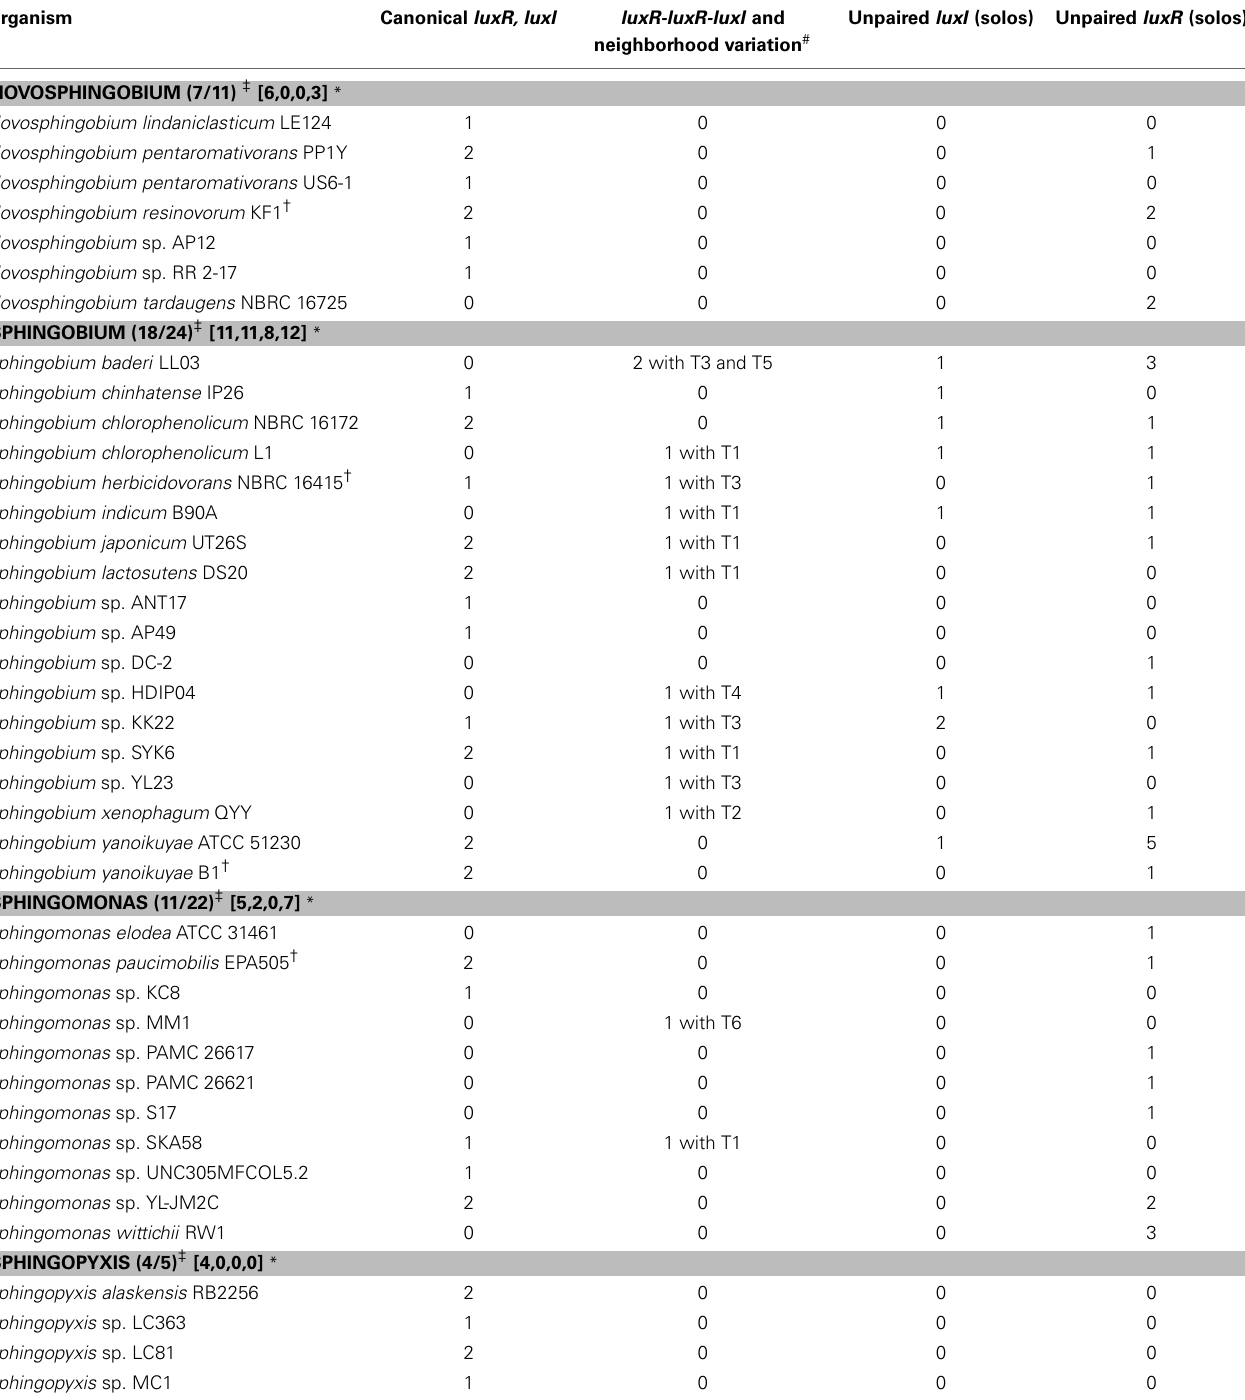
Table 3 | Distribution and organization of the luxI and luxR homologs and the presence of direct double luxR-luxI topology identified in the whole genome sequences of 40